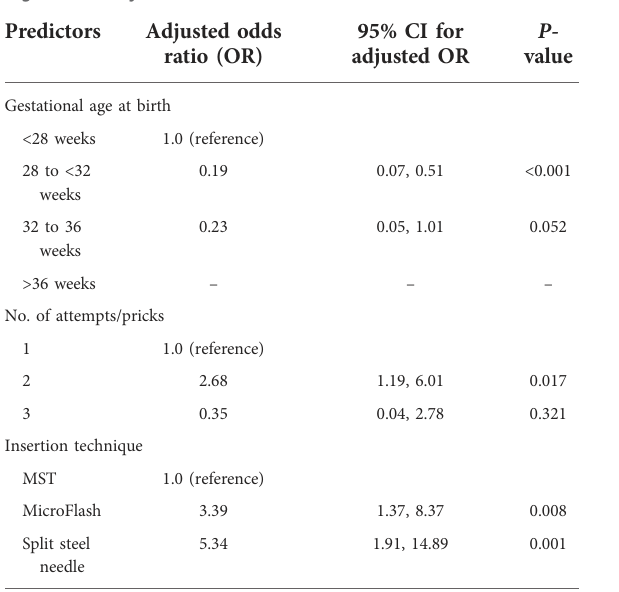
TABLE 6 Predictors associated with CLABSI: multivariate logistic regression analysis.